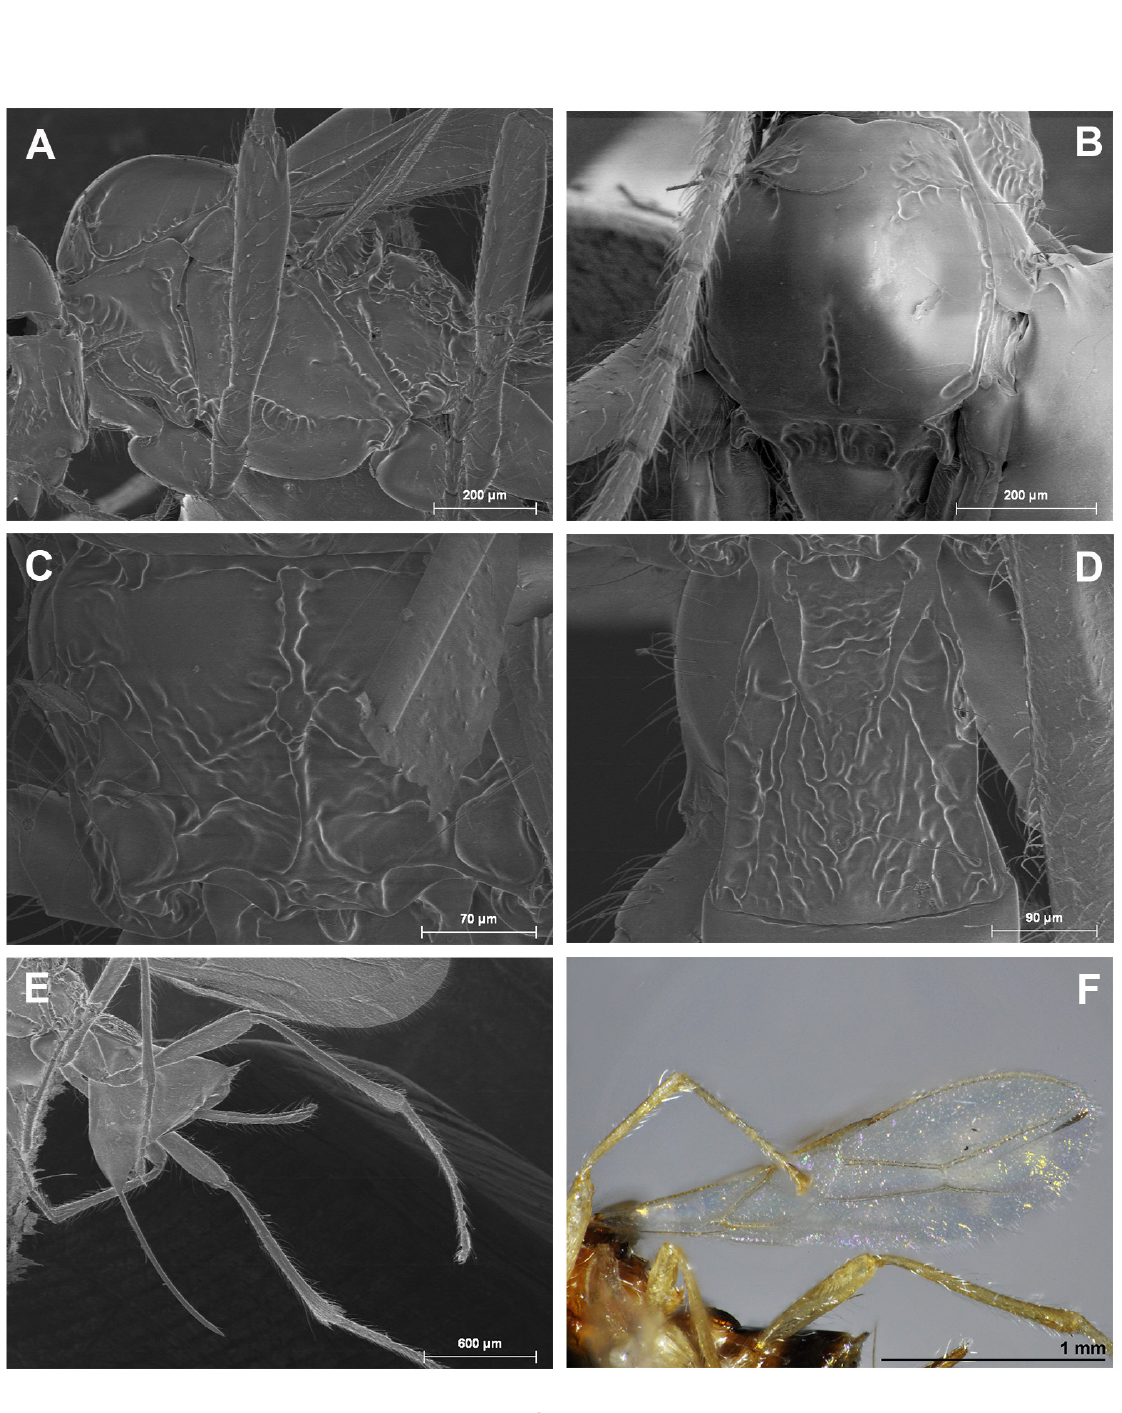
Fig. 16. Asobara epiclypealis Fischer, 2003, ♀, holotype (NHMW). A . Mesosoma, lateral view. B . Mesoscutum, dorsal view. C . Propodeum. D . First metasomal tergite, dorsal view. E . Hind leg, metasoma and ovipositor, lateral view. F . Fore